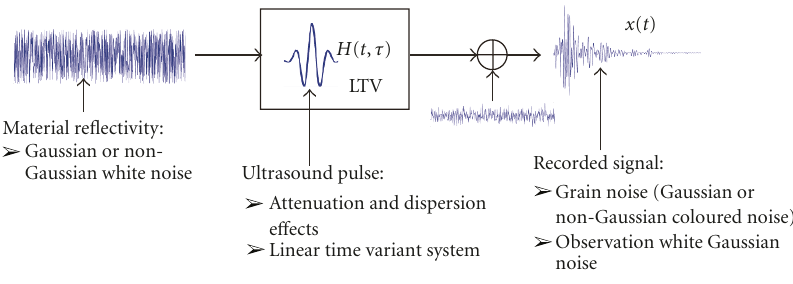
Figure 1: The through-transmission linear time variant